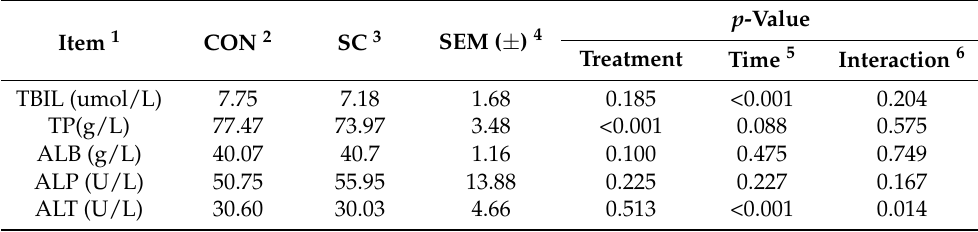
Table 3. Effects of SC on hepatic